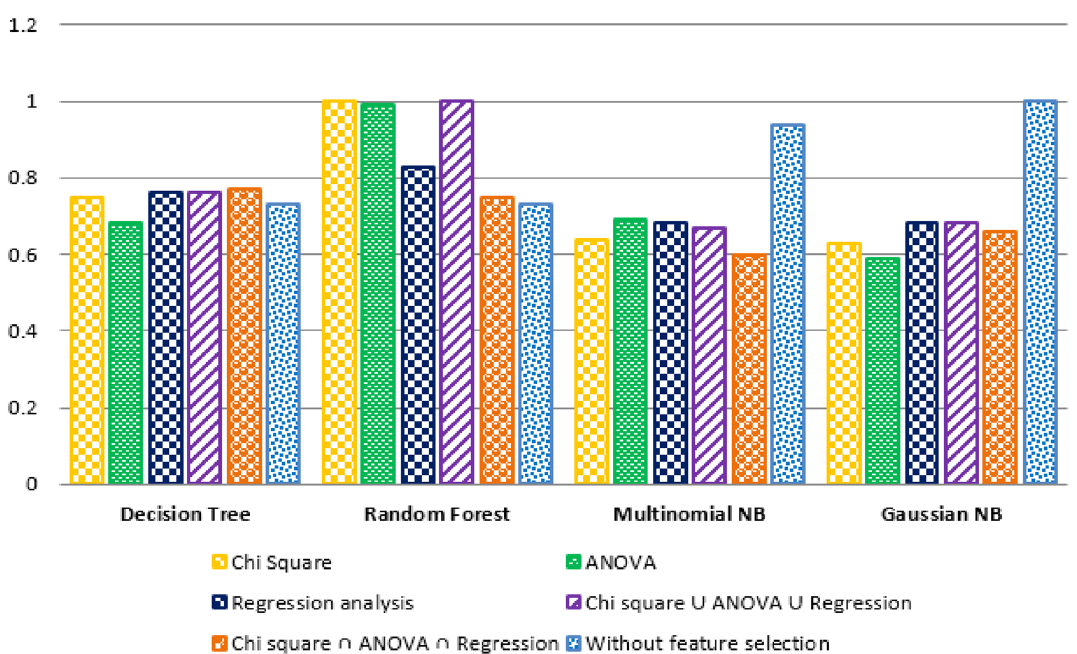
Figure 7. Comparative result of different classifiers considering precision score (feature selection and non- feature